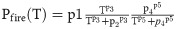
The average probability that a grid cell (500x500 m) catches fire per year as a function of tree cover.Below each figure the corresponding frequency of each tree cover class of 1% is given. A. All tropics, B. South America, C. Africa and D. Australia and Asia. Fitted line with the best AIC: Pfire(T)=p1Tp3Tp3+p2p3p4p5Tp5+p4p5. For parameters see S1 Table. See S2 Table for the precise ranges in tree cover where the fire frequency drops.